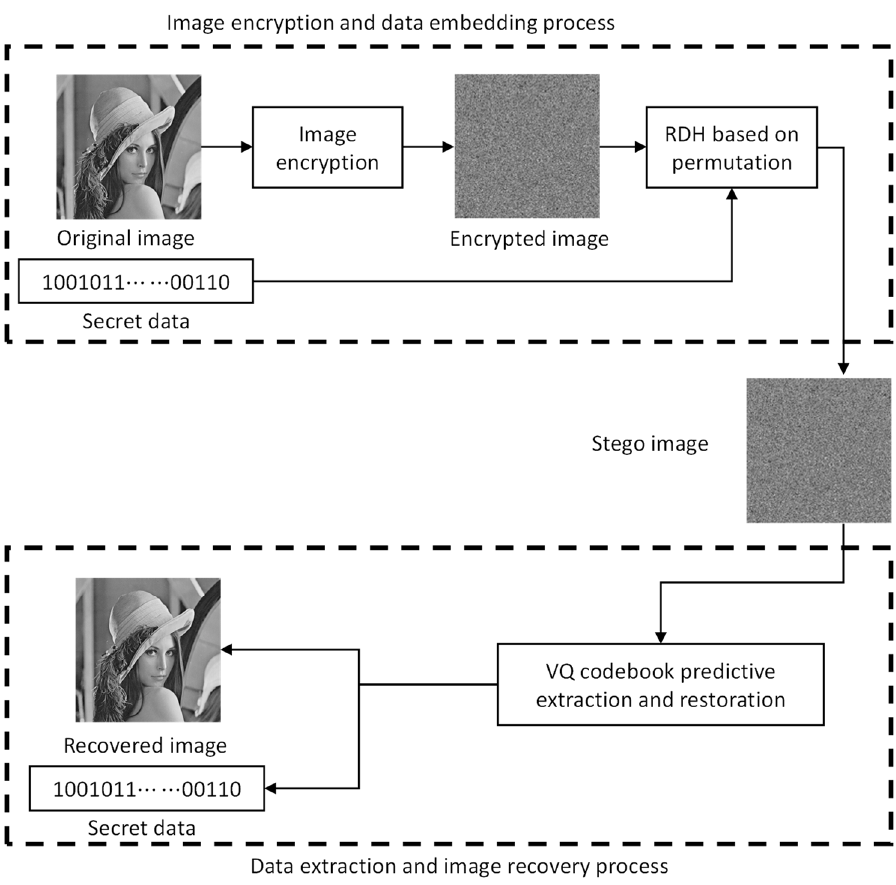
Figure 4. The overall flow of the proposed scheme P-RDHEI.